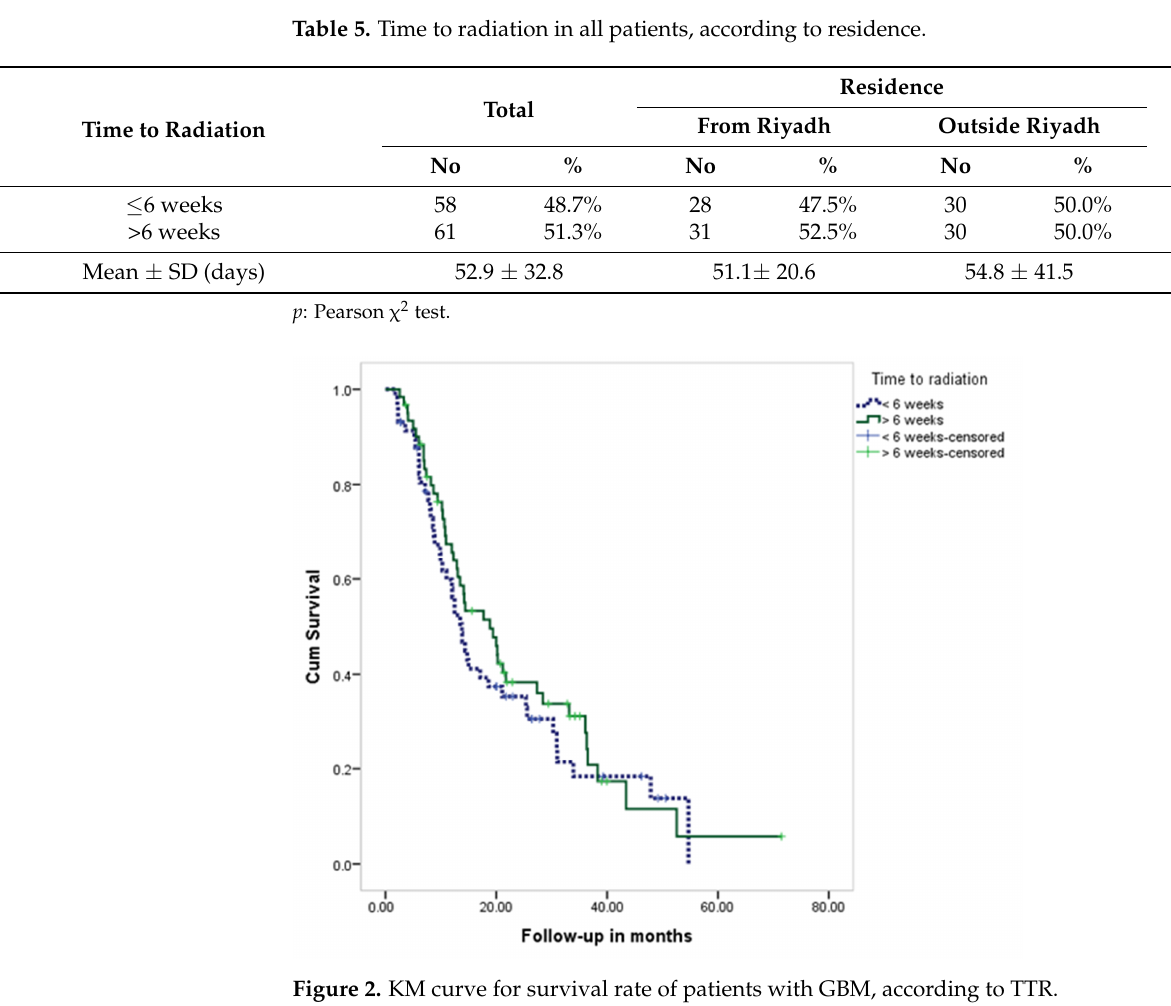
Figure 2. KM curve for survival rate of patients with GBM, according to TTR.